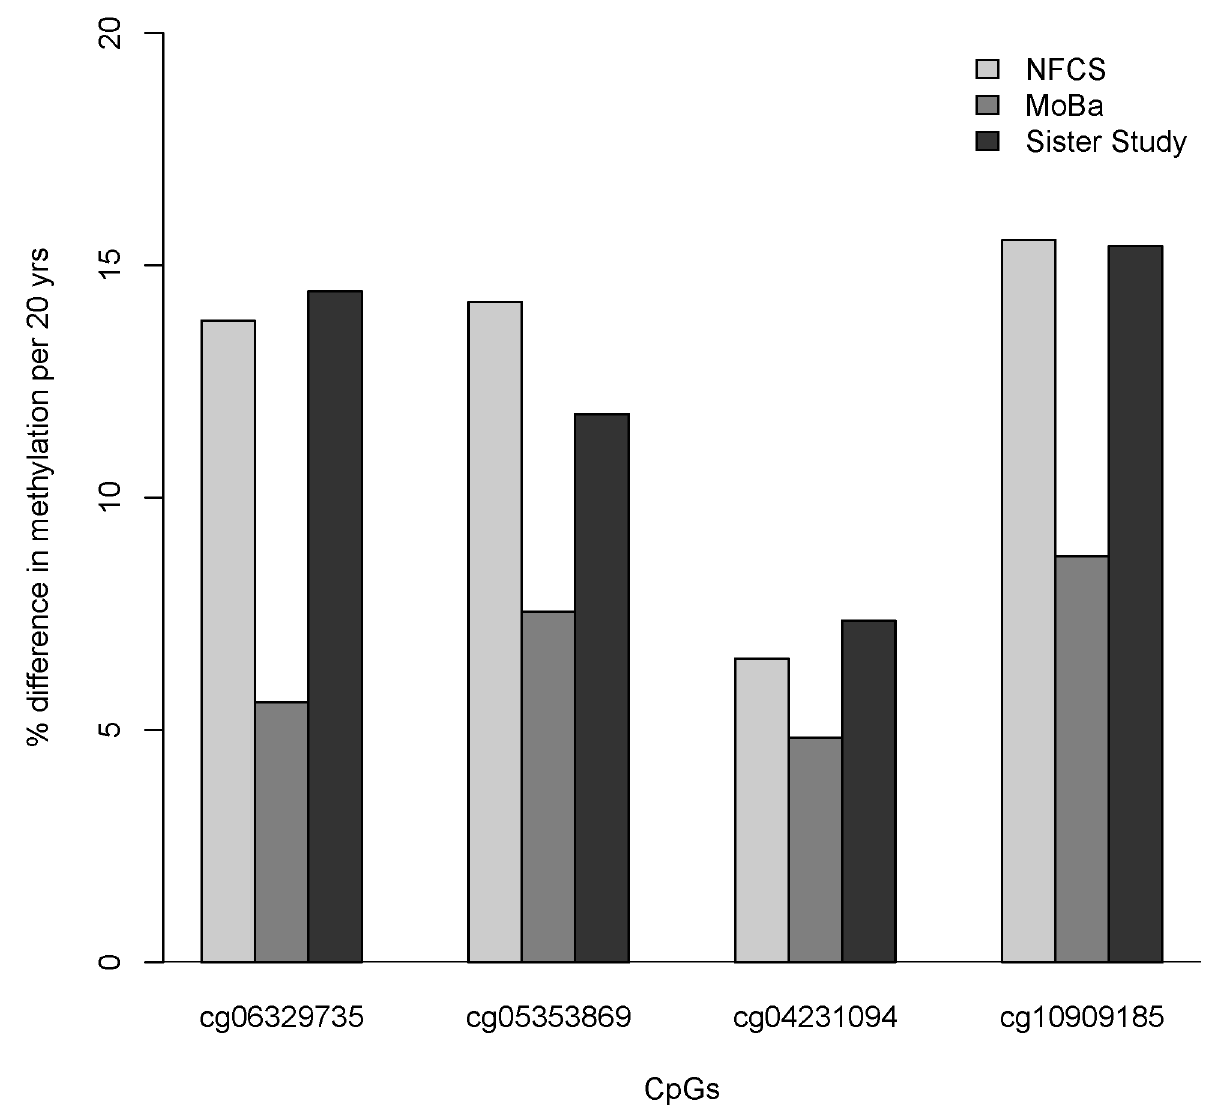
Fig 3. Maternal age-related DNA methylation changes in newborns (NFCS and MoBa) and adults (Sister Study) per 20 years. Methylation at each CpG ( β -value) was tested for association with maternal age and the β coefficients from the regression analysis were converted into the percent difference in methylation per 20 years (maternal age). The covariates included in Model1 differed slightly across the NFCS, MoBa, and the Sister Study analyses (S1 Text).